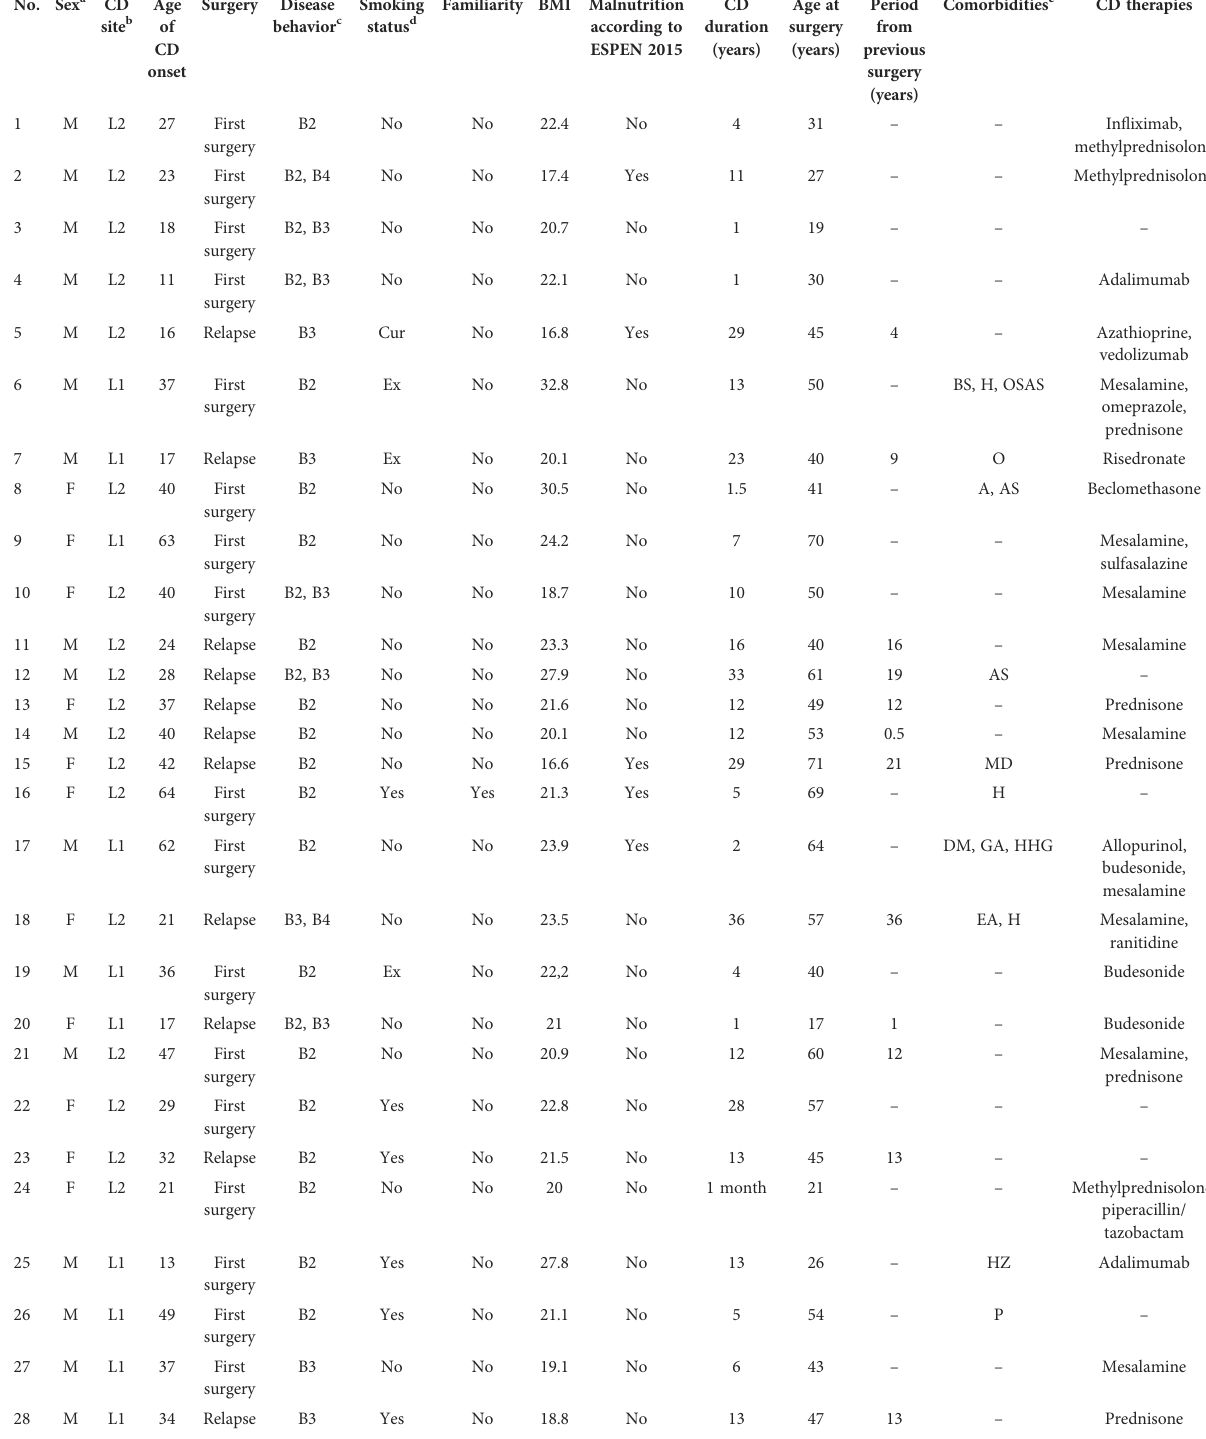
TABLE 1 Clinical features of the enrolled